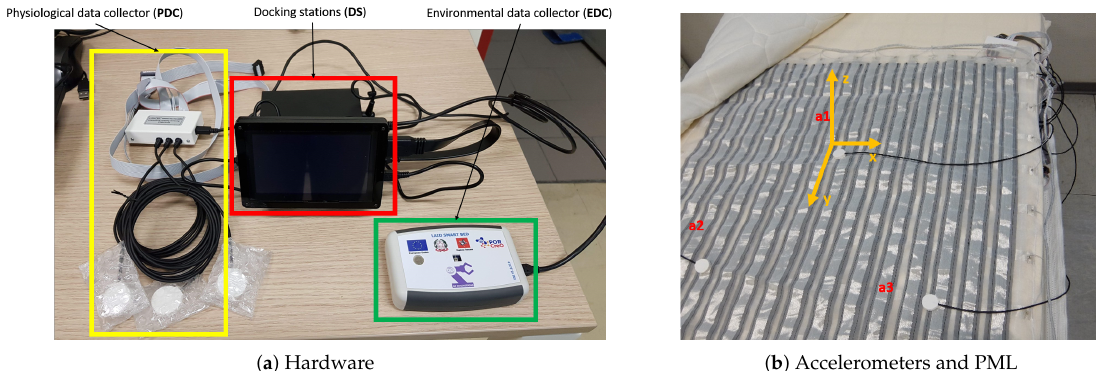
Figure 1. Smart-Bed prototype: ( a ) Functional blocks of the Smart-Bed prototype. Docking station (DS) is in the red frame, physiological data collector (PDC) in the yellow frame and environmental data collector (EDC) in the green frame; ( b ) Position of the three accelerometers ( a 1 , a 2 and a 3 ) over the pressure mapping layer (PML).